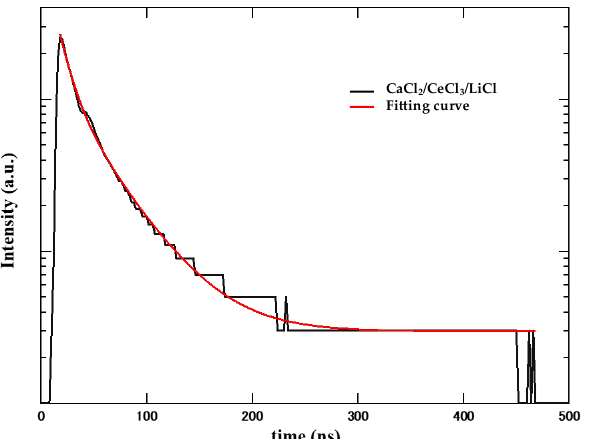
Figure 8. Scintillation decay curve of the grown eutectic sample under 252 Cf neutron excitation. The density of the eutectic crystals was calculated to be as low as 2.98 g/cm 3 . The Li concentrations of the eutectic crystal, Li glass and Ce:LiCAF were 0.031, 0.028 and 0.016 mol/cm 3 , respectively [31]. The highest Li concentration was obtained in CeCl 3 / 6 LiCl/CaCl 2 . Therefore, CeCl 3 / 6 LiCl/CaCl 2 eutectic growth was successfully applied in developing a promising scintillator for thermal neutron detection.